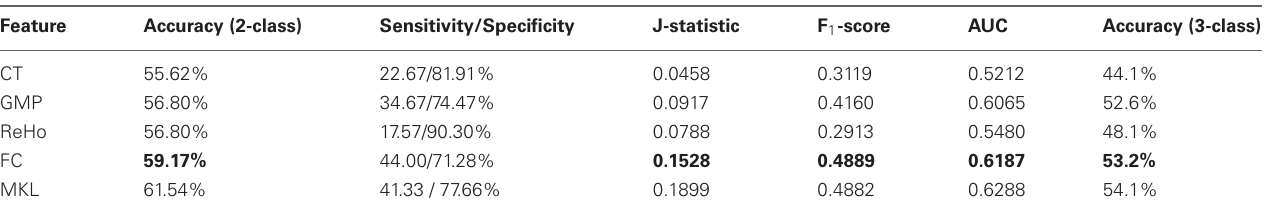
Table 4 | The classification results on test set using a single kind of feature.